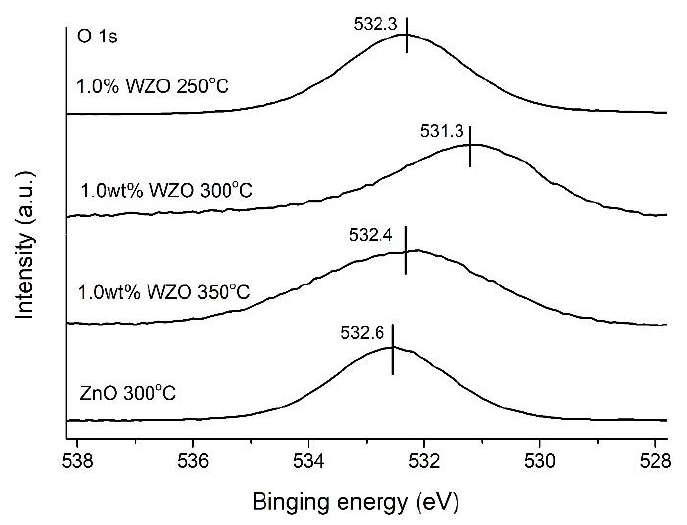
Figure 13. O 1s peak intensities of 1.0 wt.% WZO films grown at 250 – 350 °C and ZnO film grown at 300 °C.